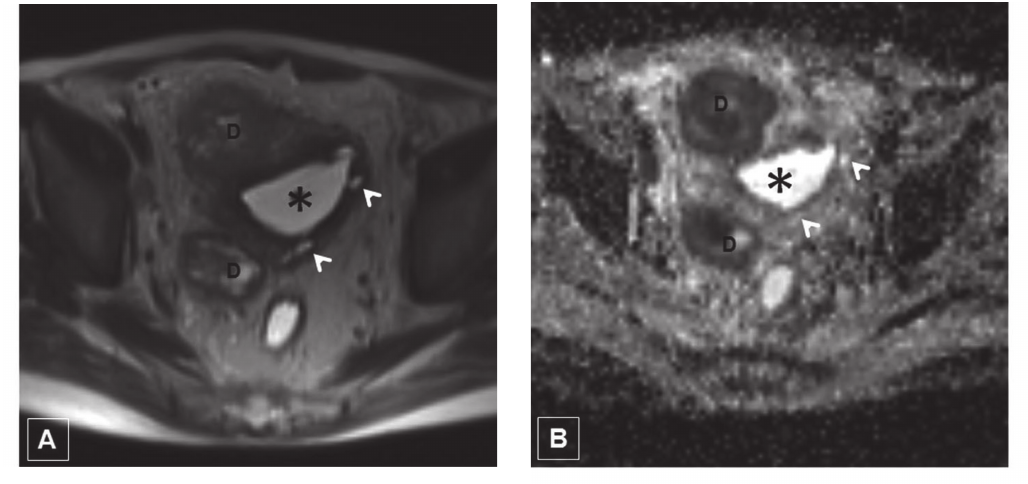
Figure 2 - Axial T2-weighted MR image (A) shows multiple bladder diverticula (D) and pseudodiverticula (arrowheads). Axial ADC image (B) shows that the diverticula (D) have a low ADC value. Asterisk: bladder.